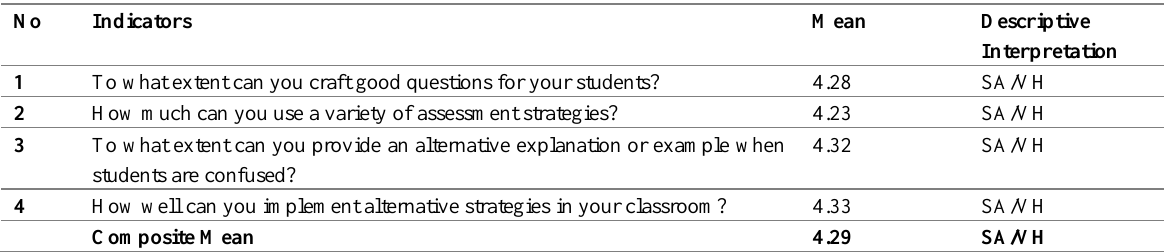
Table 2: Efficacy in Instructional Strategies.